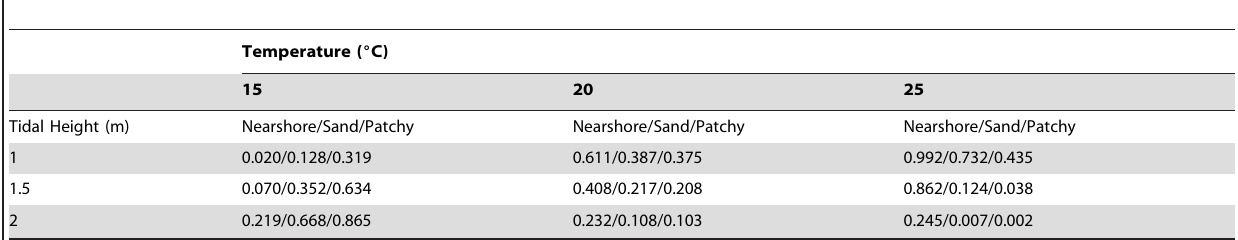
Table 2. Matrix of predicted probabilities of whipray ( Himantura uarnak and H. fai ) occurrence per microhabitat for selected temperatures and tidal heights.